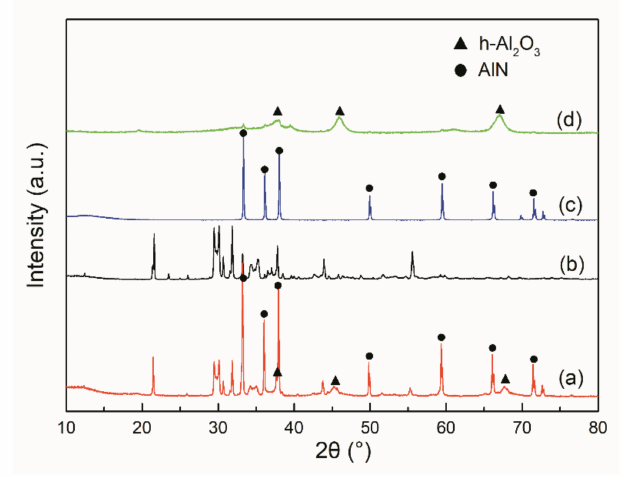
Figure 2. XRD patterns of ( a ) 15CPCMs, ( b ) eutectic salt, ( c ) AlN and ( d ) h-Al 2 O 3 . The elemental compositions of the 15CPCMs were examined by XPS analysis. As shown in Figure 3a, there are five distinct peaks in the wide-scan XPS spectrum, illustrating the existence of C, N, Al and O atoms. The group peaks near 979.7 eV are the auger electron spectra of oxygen, which is the KLL series. The C1s region consists of two strong peaks at 285.0 eV and 289.4 eV, which can be attributed to sp2-bonded carbon and MCO 3 , indicating that the composites contain carbonate. The N1s core level spectrum at 397.1 eV and 399.4 eV is related to AlN and the binding energy of O1s at 531.1 eV indicates the presence of Al 2 O 3 . Furthermore, the binding energy peak at 73.8 eV represents the Al bonded to N, which is consistent with the detection of N1s. This testing result reveals that the components of 15CPCMs include AlN, Al 2 O 3 and carbonate.